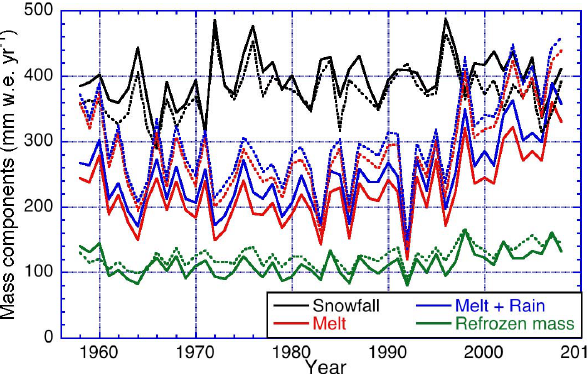
Fig. 2. Time series of ice sheet averaged annual sums of snowfall ( C ), melt ( M ), melt plus rain ( W r ), and refrozen mass ( E r ) as mod- elled in RACMO2 (solid lines) and MAR (dashed